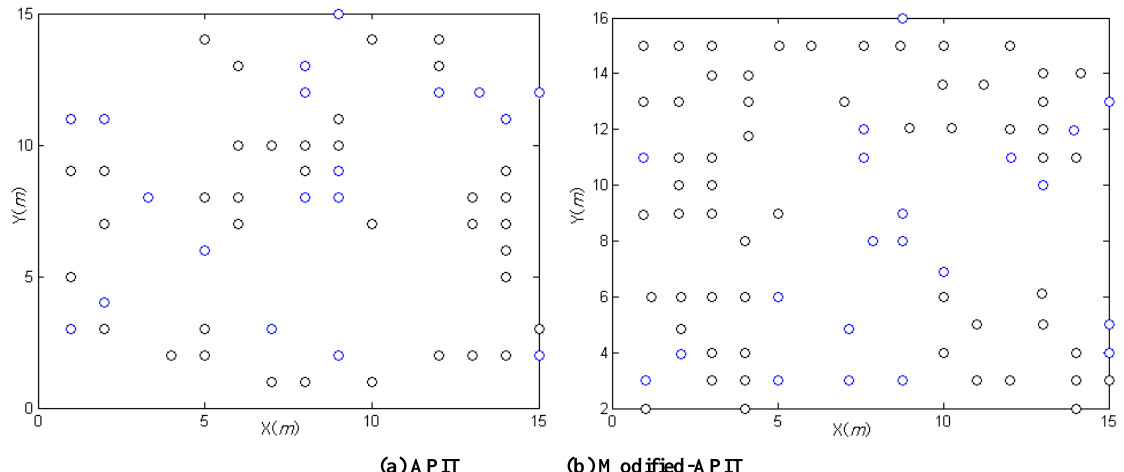
Figure 5. Localized sensors with APIT and modified-APIT.